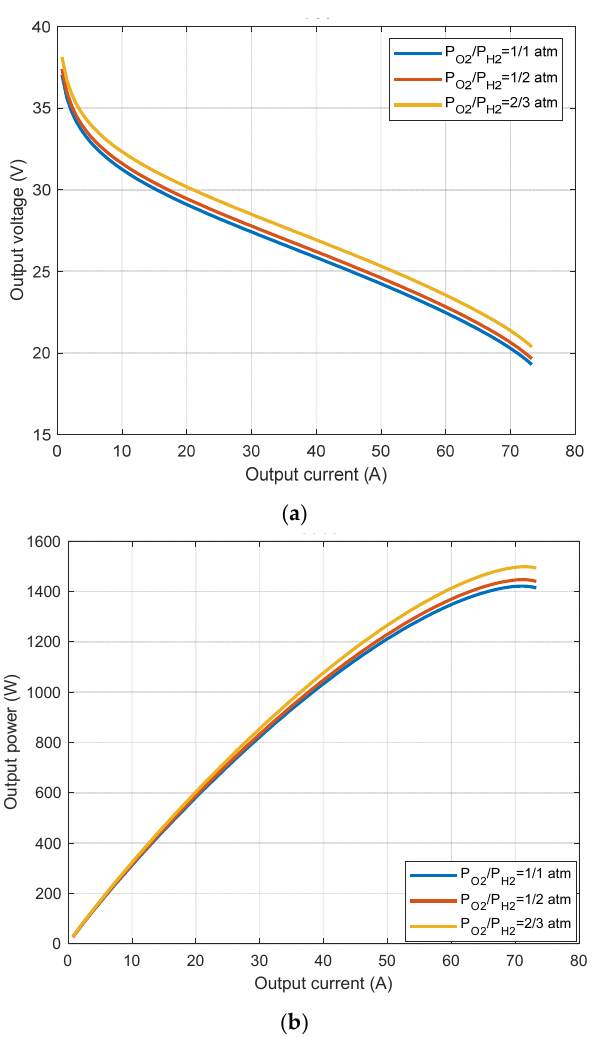
Figure 8. Characteristics of Ballard stack under various pressures: ( a ) current-voltage and ( b )